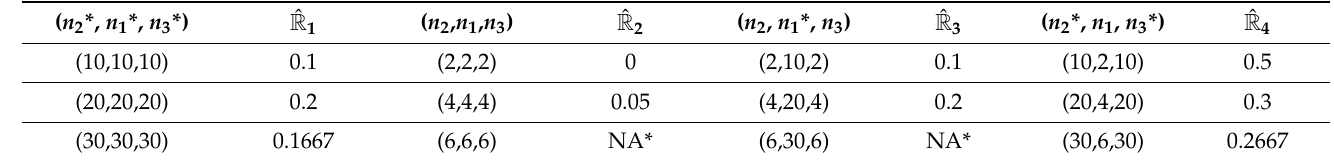
Table 11. Empirical probabilities of (Y < X < Z) using different sampling